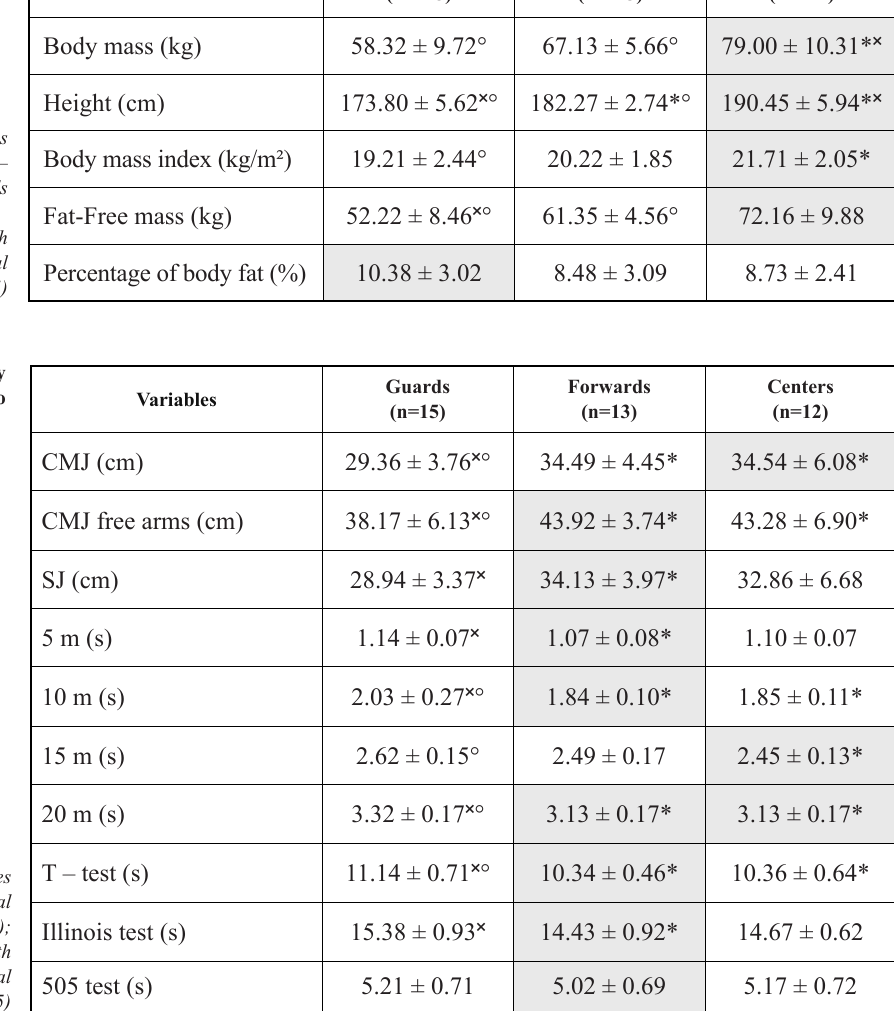
Table 1 . Anthropometric and body composition data by playing positions (mean ± SD)